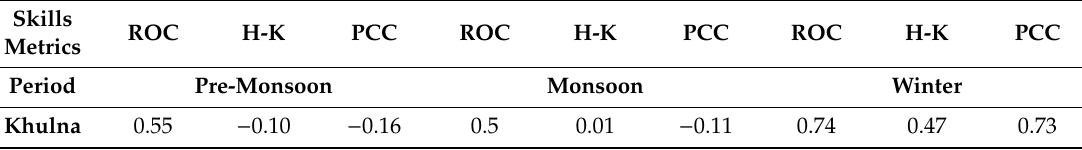
Figure 4. Skills assessment metrics (ROC, H-K and PCC) for the coastal region of Bangladesh for SEAS5 hindcasts for each of the examined seasons (pre-monsoon, monsoon, winter) and stations for the period 1981–2016. Khulna station is highlighted with a red circle. Table 1. Skills assessment metrics (Relative Operating Characteristics (ROC), Hanssen-Kuipers (H-K) and Pearson correlation coe ffi cient (PCC)) of SEAS5 forecast in relation to the observations for Khulna station under lead time